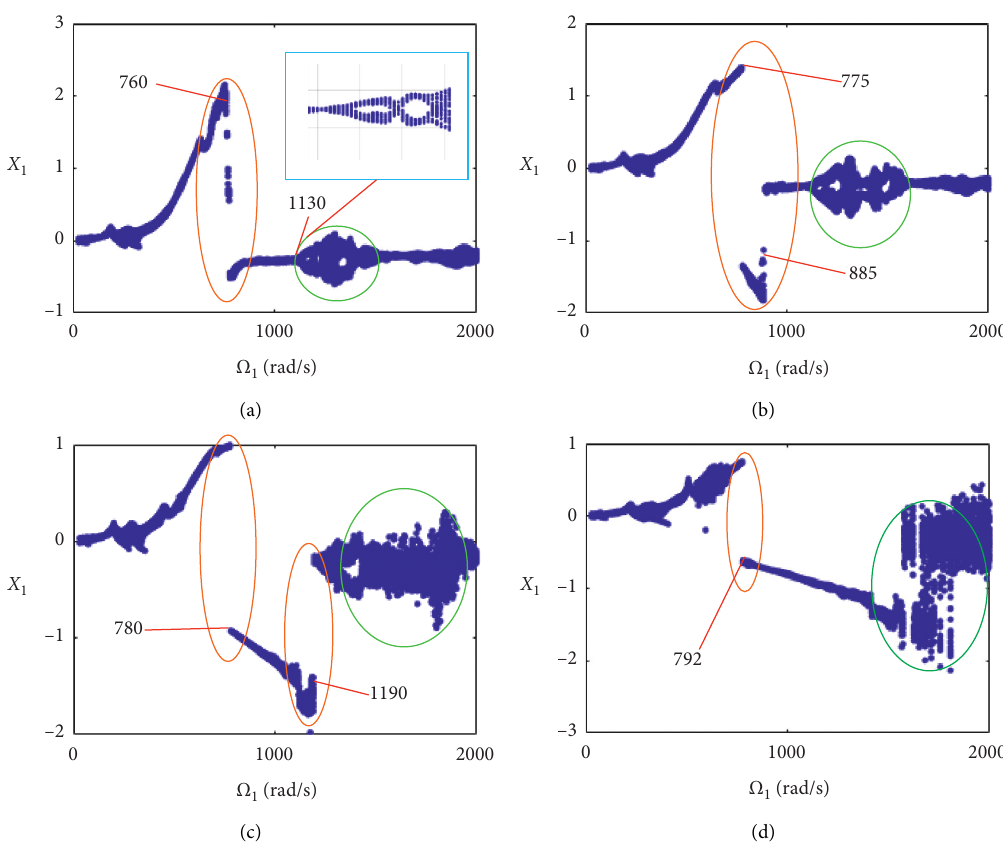
1 versus the rotational speed Ω 1 rad/s for the clearance